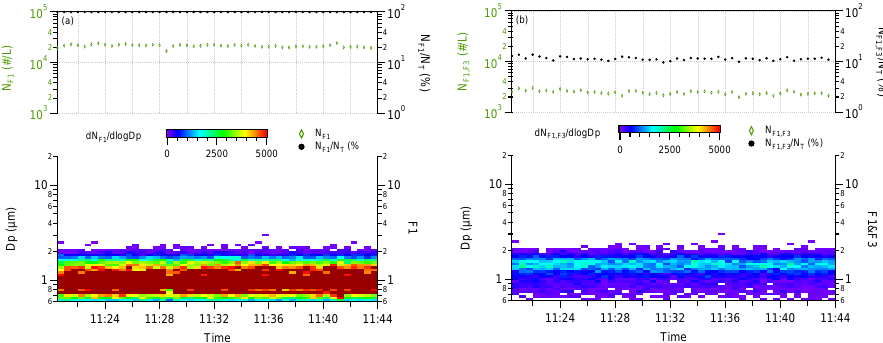
Fig. 6. WIBS-4 fluorescence data for Pseudomonas syringae type of bacterium isolated from cloud water. Fluorescence data were col- lected during a cloud experiment conducted during BIO-05 campaign. Average residence time of the bacterial species in the chamber was approximately 1 h. The physical size of the bacterial strains was around 1.0µm. The data are plotted in the same way as in Fig.